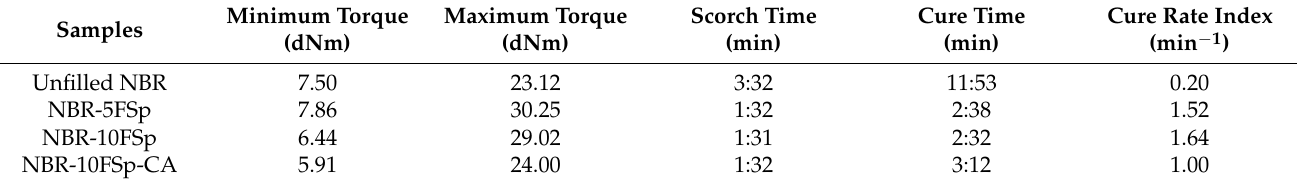
Table 3. Cure characteristics of NBR/FSp and NBR/FSp/CA